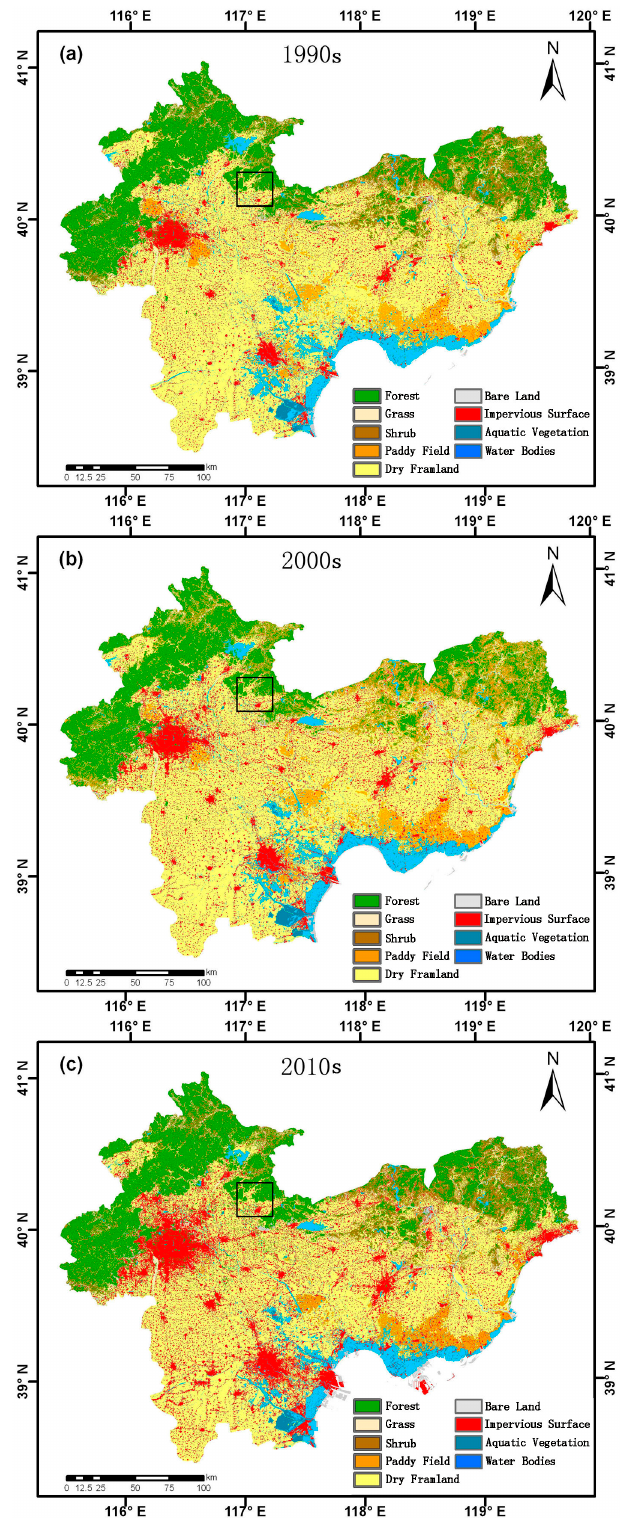
Figure 7. Classifications of the Beijing-Tianjin-Tangshan (BTT) region for 1990, 2000 and 2010: ( a ) land cover in 1990; ( b ) land cover in 2000; and ( c ) land cover in 2010. The area that is indicated by the black rectangle is shown in detail in Figure 4.